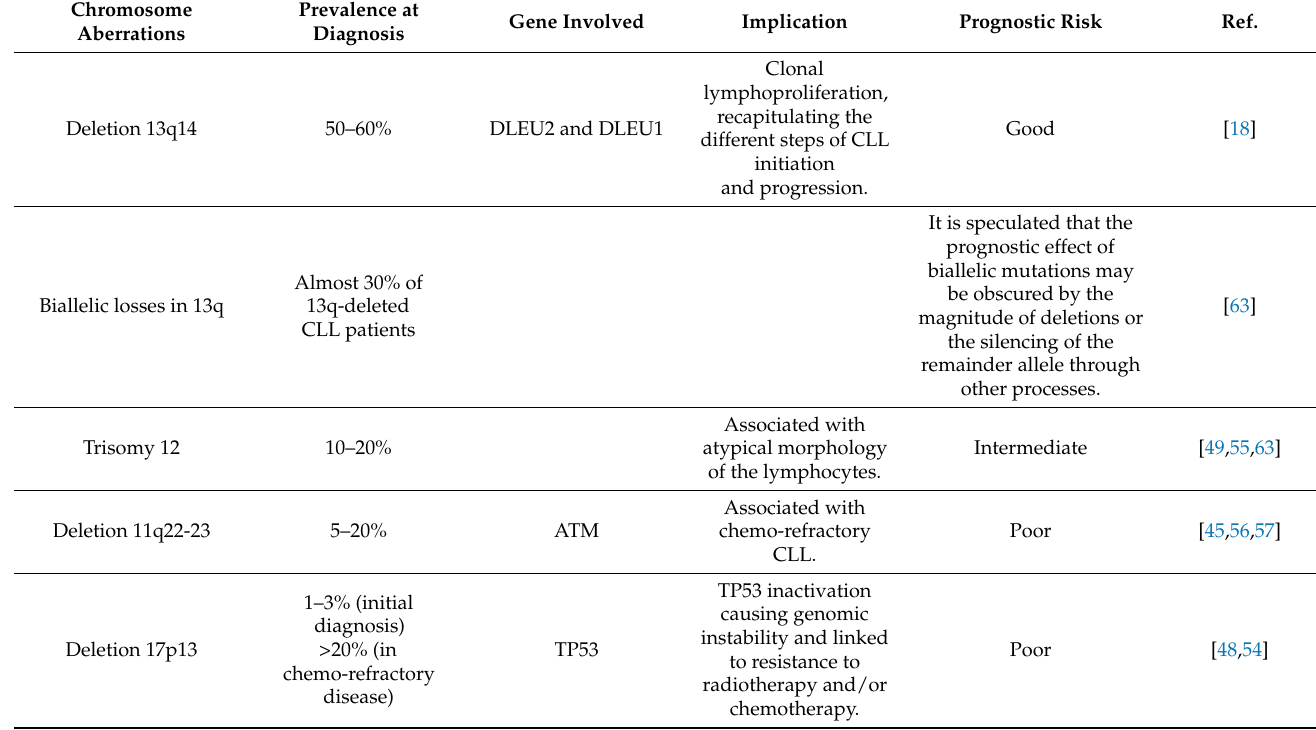
Table 1. The common chromosome aberrations in CLL tested by FISH.